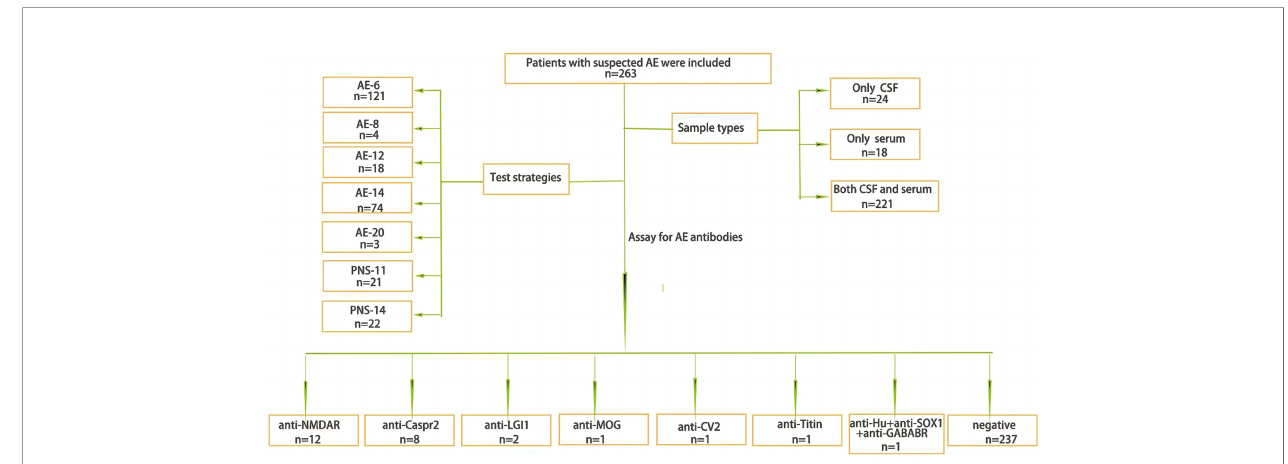
FIGURE 1 | The general situation. The general situation of AE antibody testing samples and test strategies and the